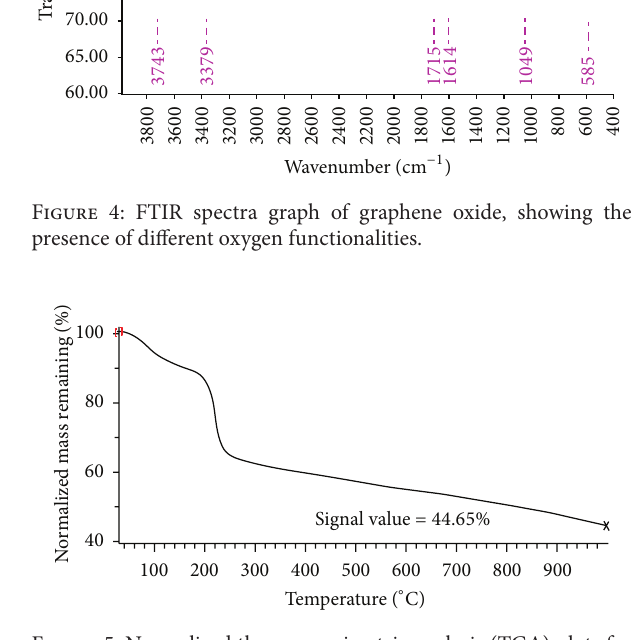
Figure 5: Normalized thermogravimetric analysis (TGA) plots for